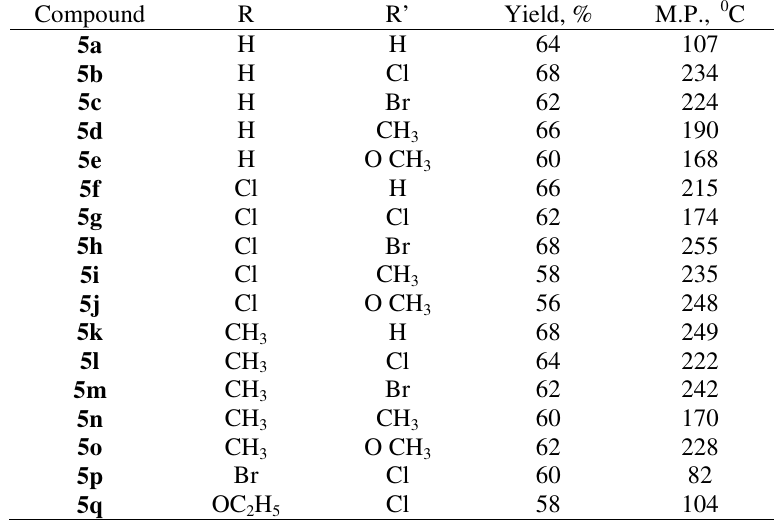
Table 3. Characterization data for the synthesized compounds ( 5a-q )